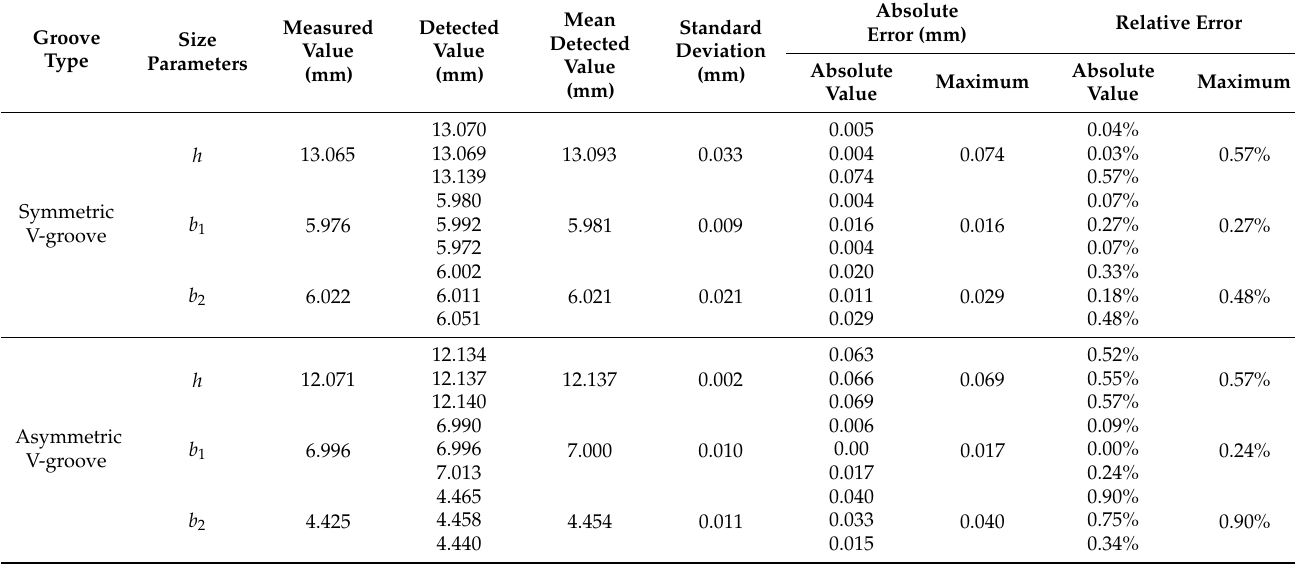
Table 3. V-grooves size parameters detection of planar